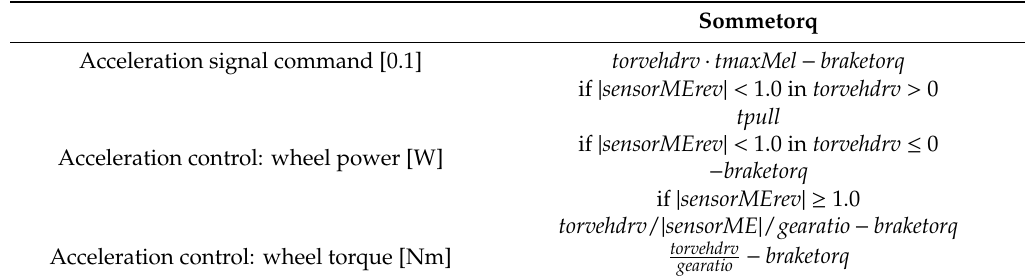
Table 4. Torque command.